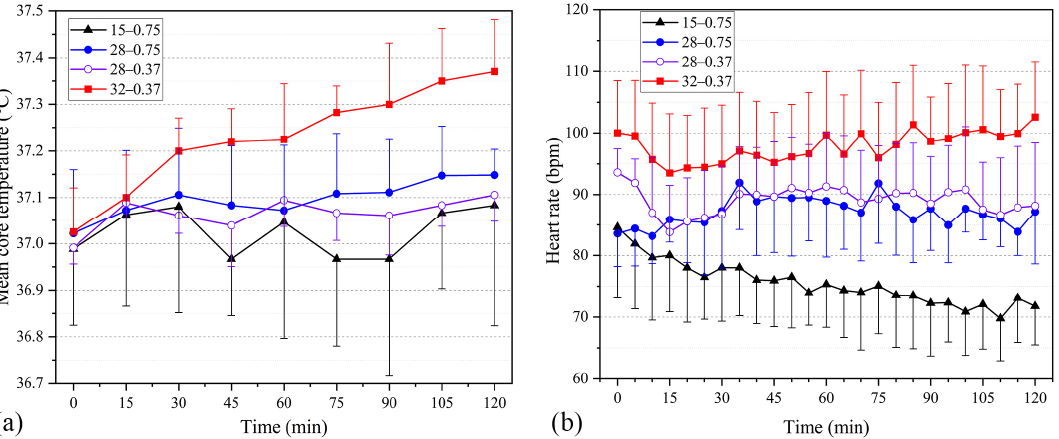
Figure 6. Temporal variation of T core and HR under four different working conditions (i.e., 15 °C – 0.75 clo, 28 °C – 0.75 clo, 28 °C – 0.37 clo, 32 °C – 0.37 clo; testing scenarios in the figures are presented as A–B, where A represents the WBGT value and B represents the insulation of the inner garments used in the testing). ( a ) Mean core temperature. ( b ) Heart rate.